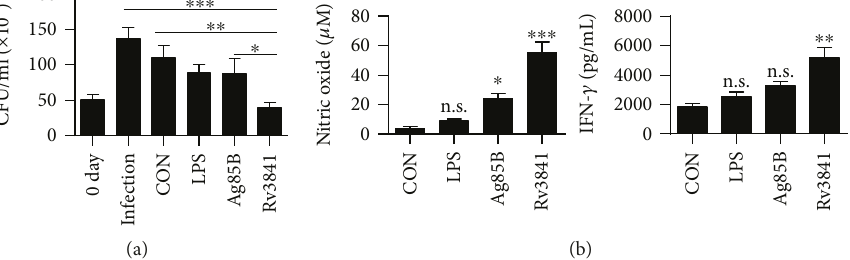
Figure 7: T-cells activated by Rv3841-treated DCs inhibit intracellular Mtb growth. Splenic T-cells or T-cells from Mtb-infected mice activated by unstimulated DCs, LPS-stimulated DCs, Ag85B-stimulated DCs, or Rv3841-stimulated DCs at a DC:T-cell ratio of 1: 10 for 3 days were cocultured with BMDMs infected with Mtb. (a) Intracellular Mtb growth in BMDMs was determined at time point 0 (day 0) and 3 days after culturing with T-cells or without T-cells (control). (b) The NO and IFN- γ levels in culture supernatants were determined. The data are shown as mean ± SD ( n = 3 ); ∗ p < 0 05 , ∗∗ p < 0 01 , or ∗∗∗ p < 0 001 : a signi fi cant di ff erence of BMDMs cocultured with T-cells from control BMDMs. n.s.: no signi fi cant di ff